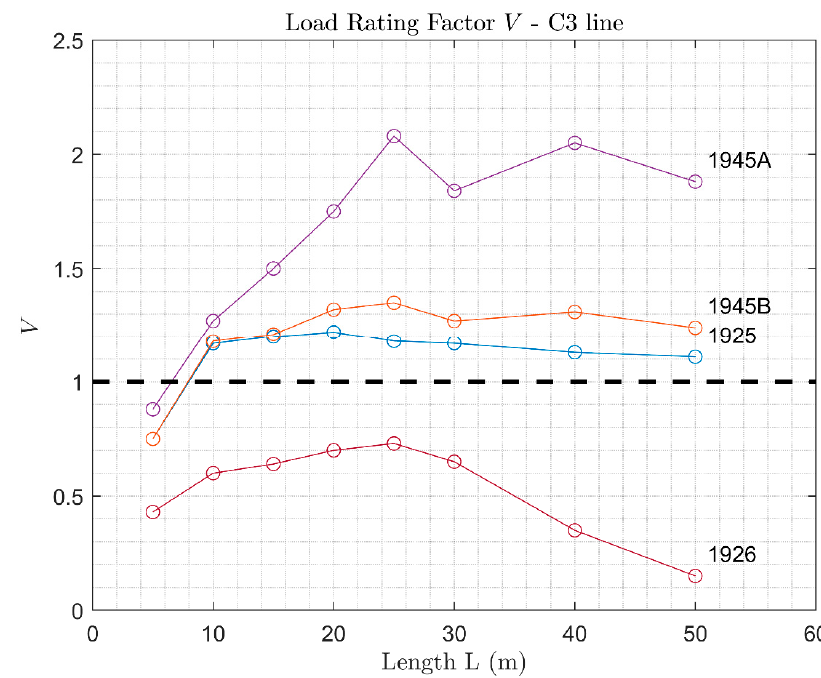
Figure 12. Load Rating Factor of arches verified with C3 loads.